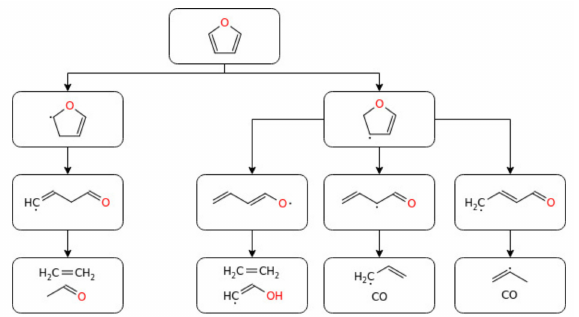
Figure 15. A simplified reaction pathway for furan